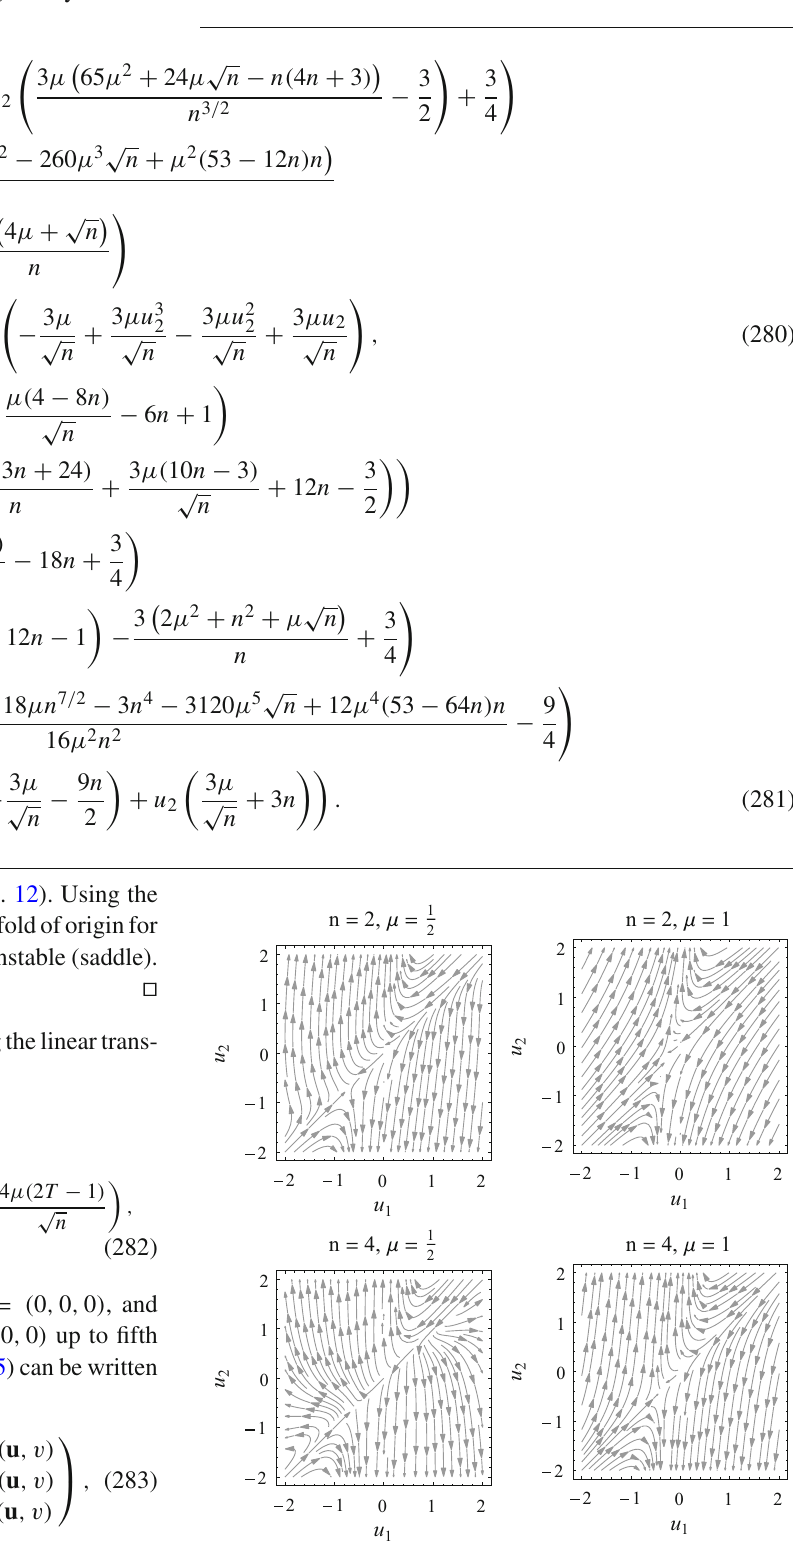
Fig. 12 Numerical solutions of the system (280) shows the instability of the origin ( u 1 , u 2 ) = ( 0 , 0